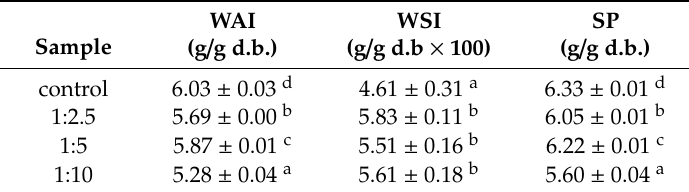
Table 2. Water Absorption Index (WAI), Water Solubility Index (WSI) and Swelling Power (SP) values of samples from di ff erent ultrasound